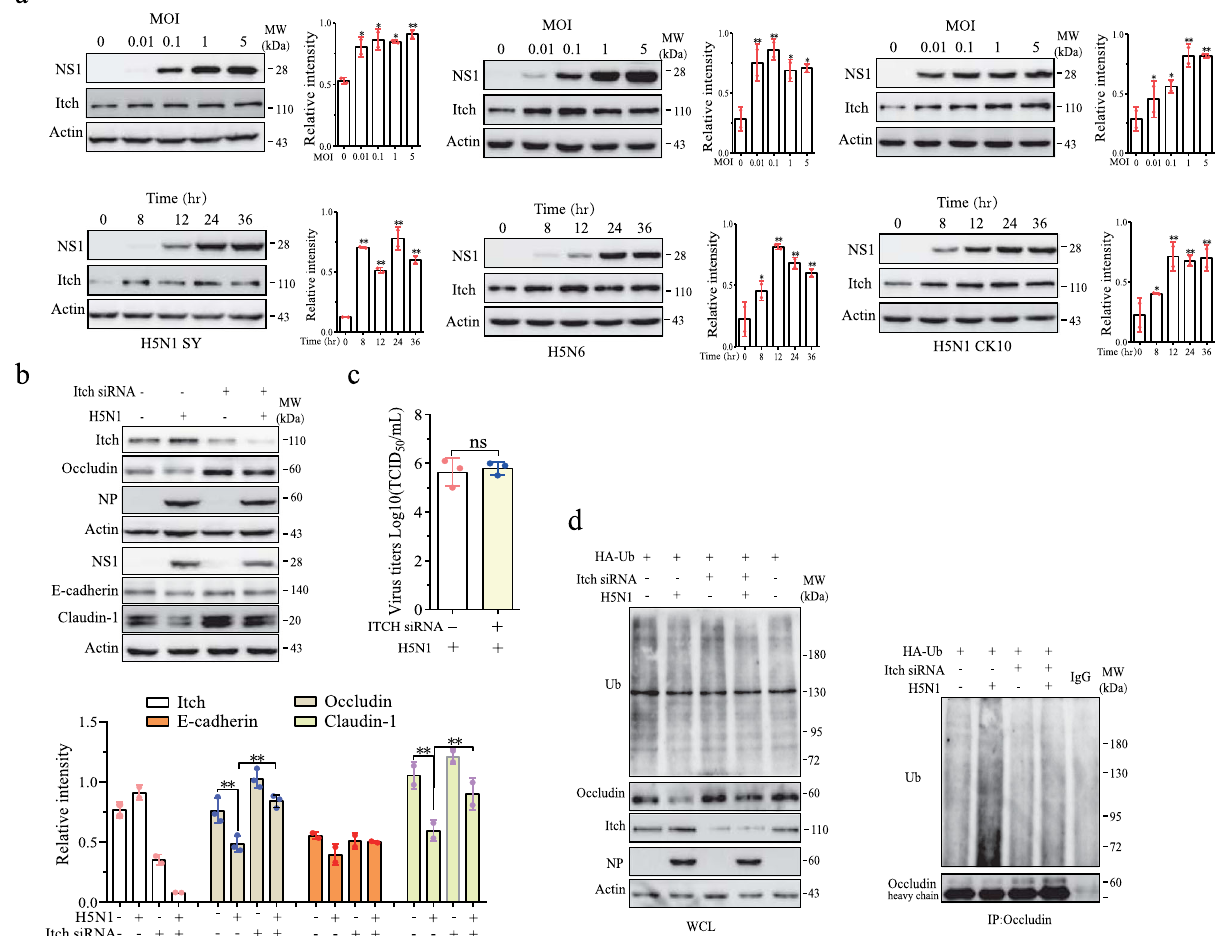
Fig. 3 H5N1 viruses degrade intercellular junction proteins by inducing Itch expression. a H5N1 viruses induce Itch expression. A549 cells were infected with various MOI of two H5N1 strains (SY and CK10) and H5N6 viruses (the Y6 strain) for 24 hr or with these viruses (1 MOI) for the indicated lengths of time. Cell lysates were analyzed for the levels of Itch and actin by Western blot. b Itch knockdown blocks H5N1 virus-induced downregulation of junction proteins. A549 cells were transfected with a scrambled control or Itch siRNA. After incubation for 24 h, the cells were left uninfected or infected with H5N1 virus (1 MOI) and incubated for another 24 h. Cell lysates were analyzed for the levels of Itch and junction proteins by Western blot with the indicated antibodies. c The conditioned media from H5N1 virus-infected cells were analyzed for virus titers by measuring the TCID50 values. d Itch knockdown blocks H5N1 virus-induced occludin ubiquitination. A549 cells were transfected with a scrambled control or Itch siRNA plus the expression vector encoding HA-ubiquitin. After incubation for 24 h, the cells were left uninfected or infected with H5N1 virus (1 MOI) and incubated for another 24 h. Cell lysates were immunoprecipitated with an antibody against occludin. Normal mouse IgG was included as a negative control. Whole-cell lysates (WCL) and immunoprecipitates were analyzed with antibodies against ubiquitin, NP, occludin, and β -actin. The data represent one of three independent